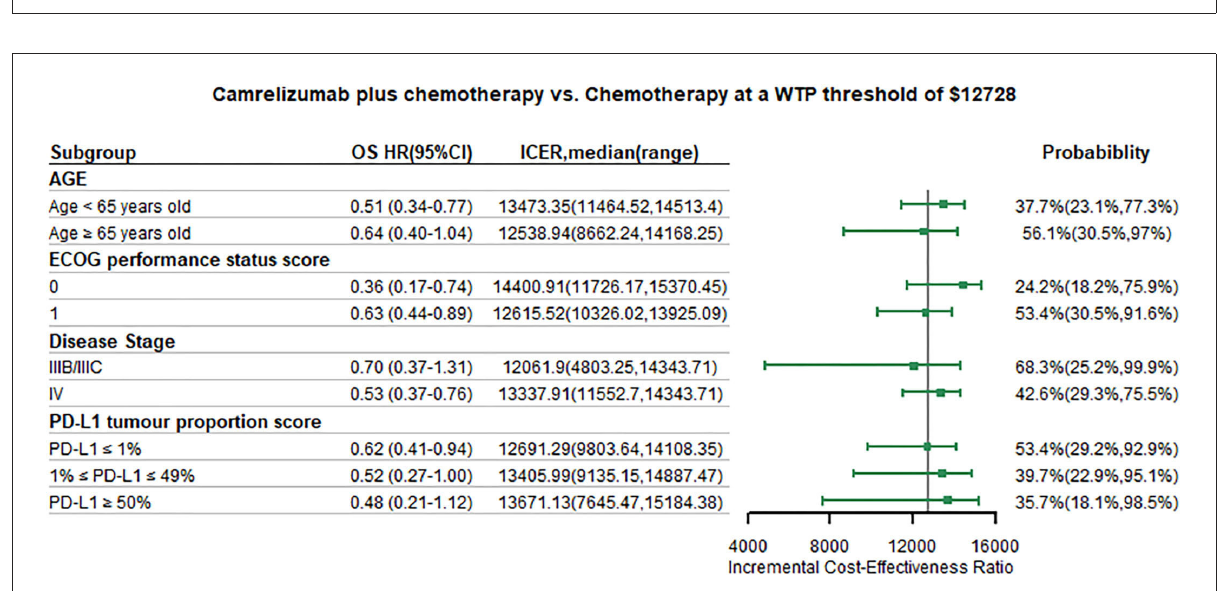
FIGURE6 Subgroup analysis results of incremental cost-effectiveness ratio (ICER) and probabilities of cost-effectiveness obtained by varying the hazard ratios (HRs) for overall survival. WTP, willingness-to-pay; OS, overall survival; HR, hazard ratio; CI, confidence interval; ICER, Incremental cost-effectiveness